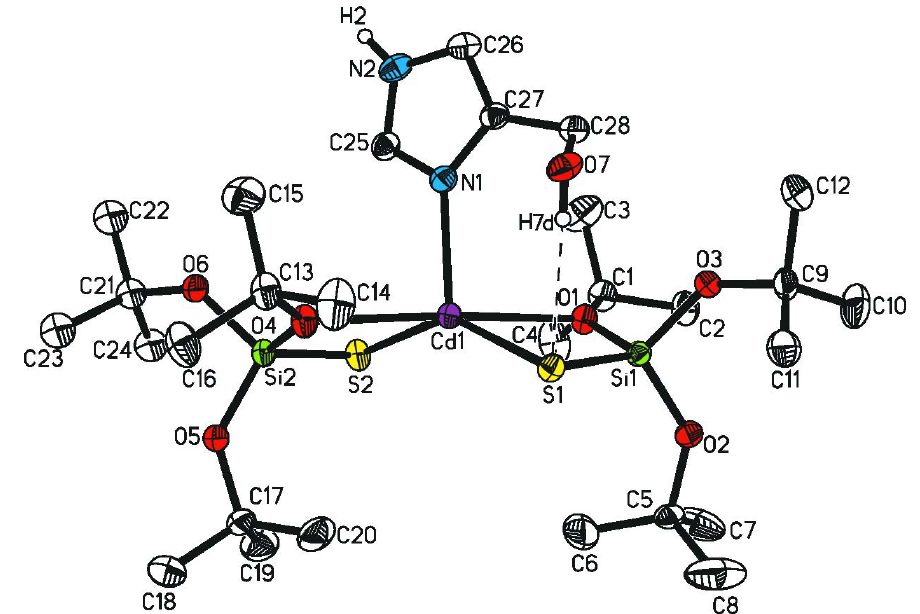
Figure 1 A view of the title molecule, showing the atom-labelling scheme. Displacement ellipsoids are drawn at the 50% probability level and H atoms, except those from OH and NH groups, have been omitted. Hydrogen bonds are indicated with dashed lines. Only the major conformation for the disordered methyl groups (C24-C25) is